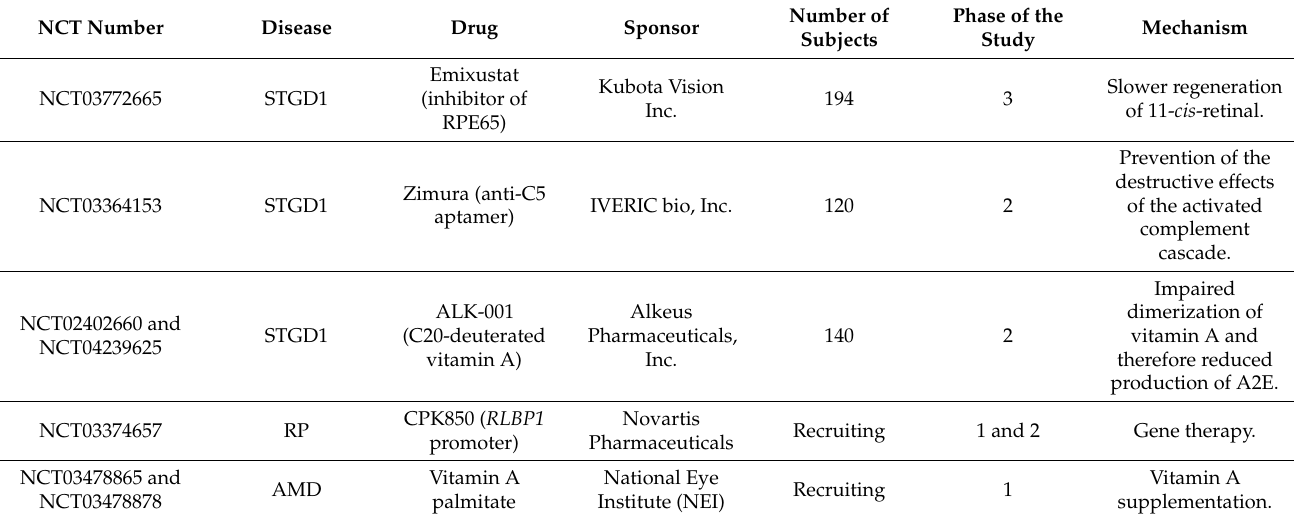
Table 2. Summary of the relevant clinical